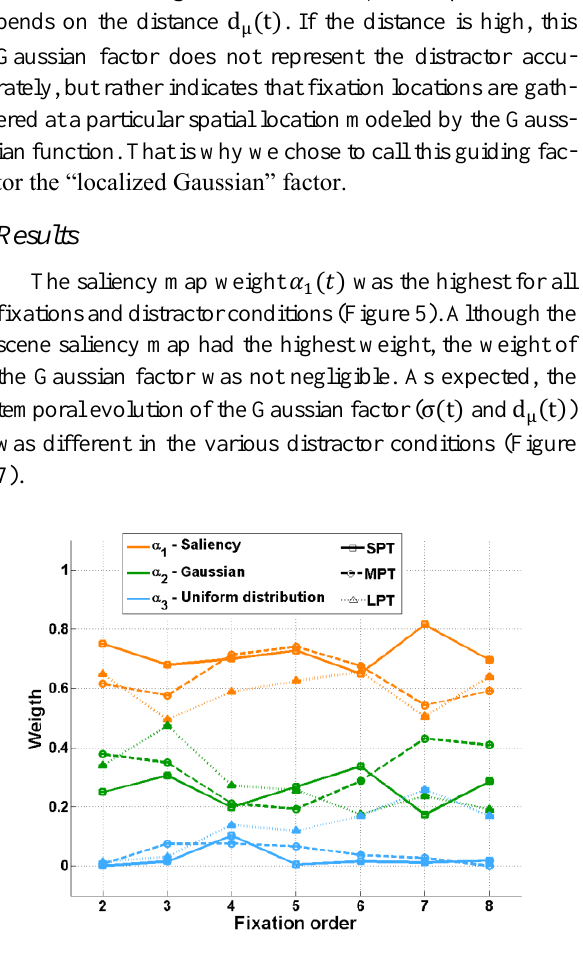
Figure 5: Contributions (weights) of the three factors for the three distractor conditions SPT, MPT and LPT as a function of fixation order. Mean estimations across initializations and corresponding standard errors are plotted. Note that standard error bars are really